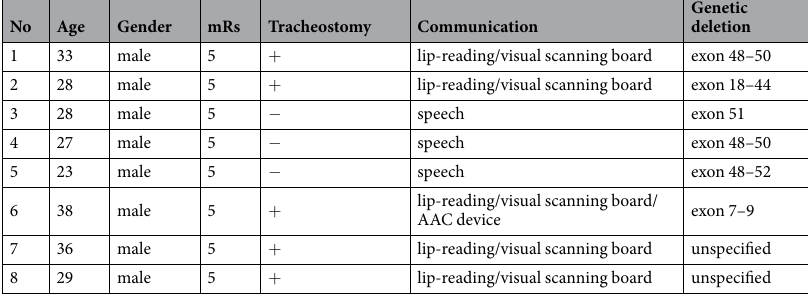
Table 1. Demographic and clinical characteristics of the patients with DMD.